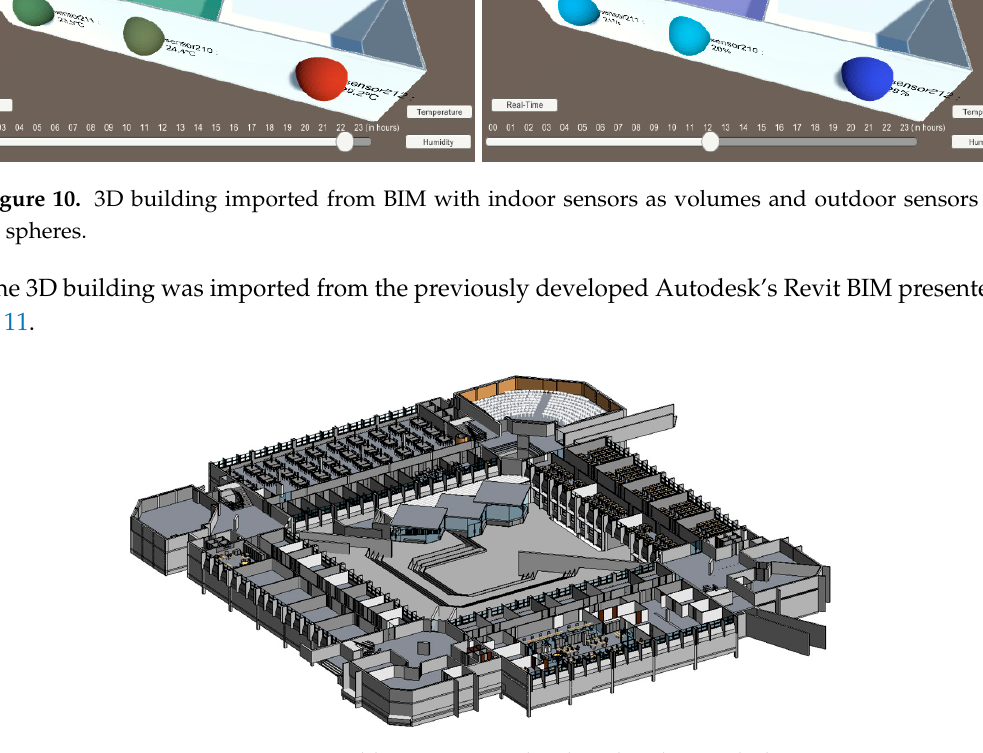
Figure 11. ISCTE-IUL Building I, 3D BIM developed with Autodesk’s Revit.